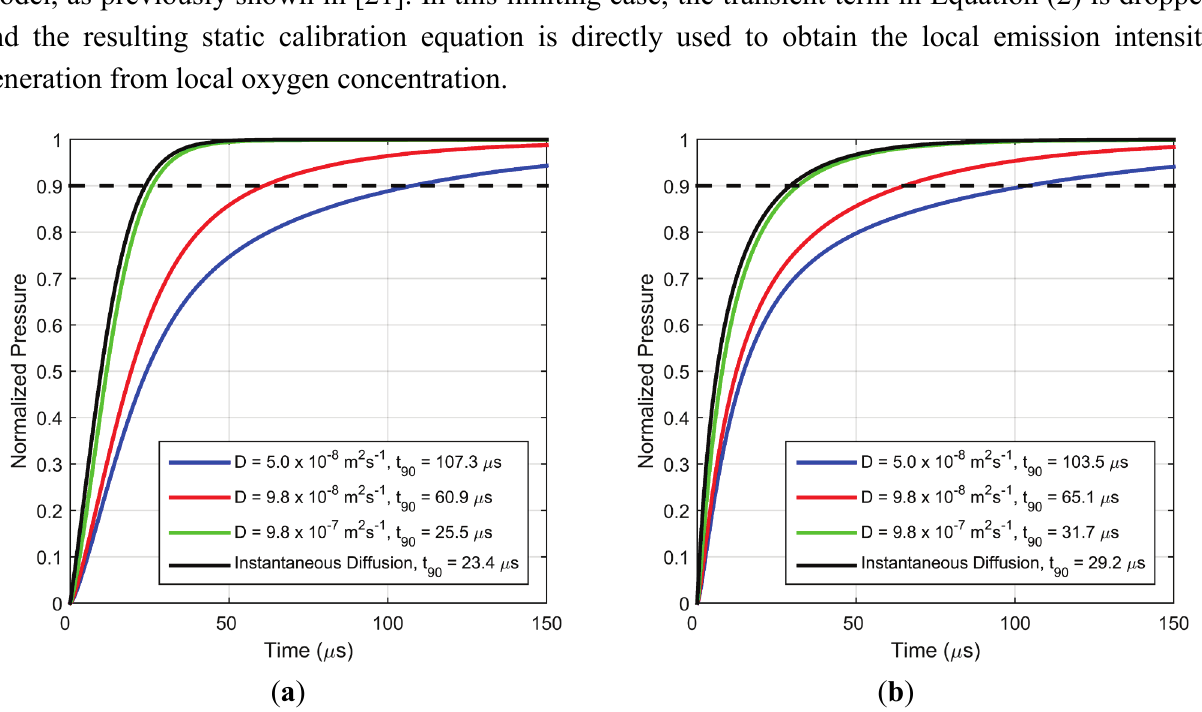
Figure 13. Simulated pressure response for ( a ) step increase in pressure from vacuum to 1 atm. and ( b ) step decrease in pressure from 1 atm. to vacuum, for different values of diffusion coefficient.